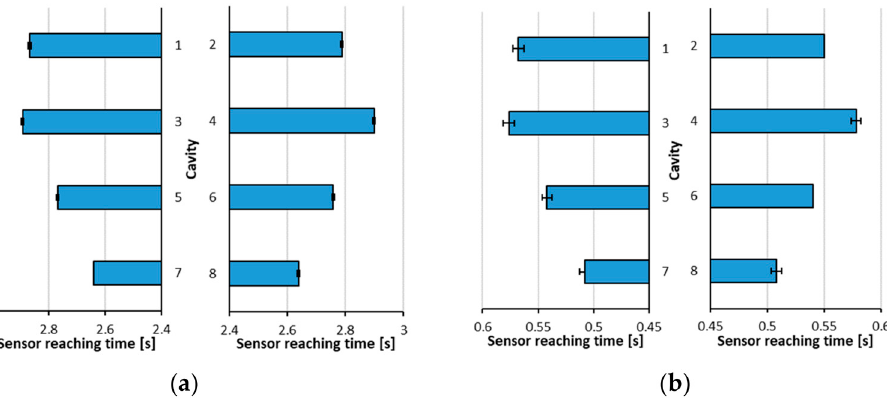
Figure 9. Melt arrival times to the end-of-cavity sensors: ( a ) v inj = 10 cm 3 /s and for ( b ) v inj =110 cm 3 /s ( T melt = 215 ◦ C).